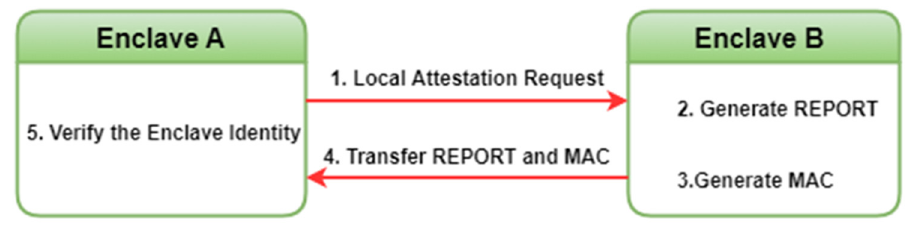
Figure 2. SGX attestation flow of local attestation.